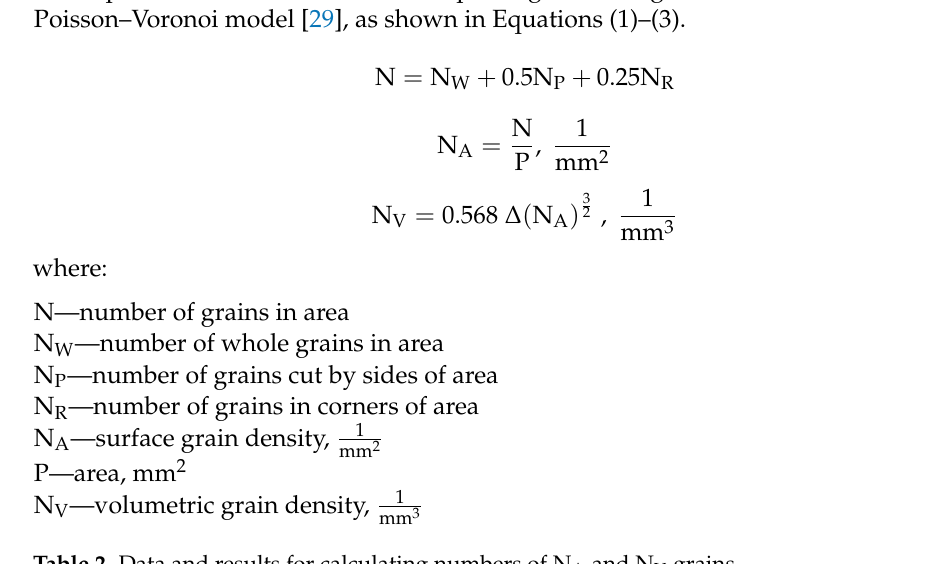
Table 2. Data and results for calculating numbers of N A and N V